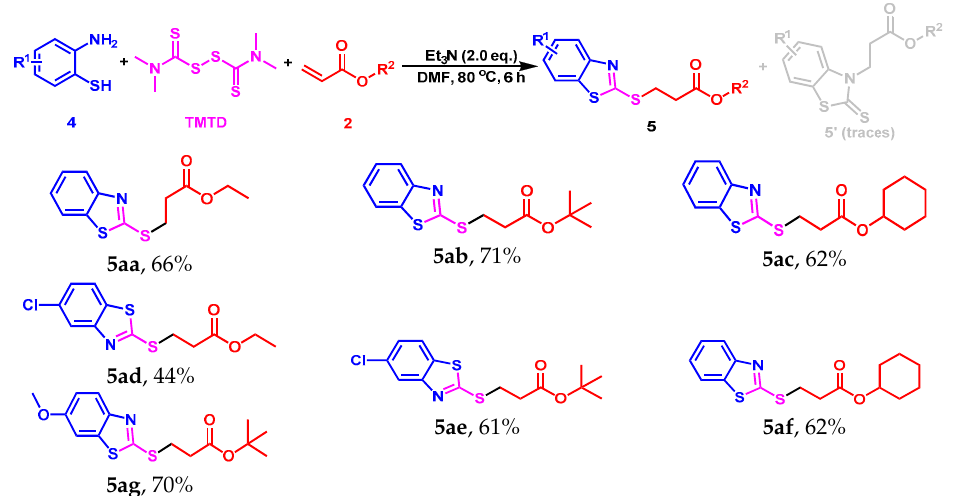
Table 3. One-pot synthesis of benzothiazole-substituted ester compounds a,b .